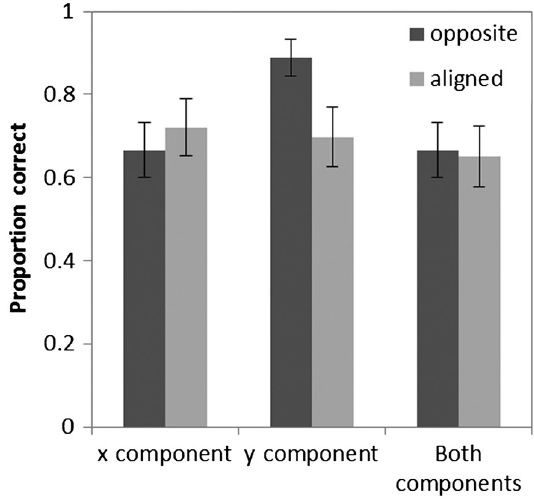
FIG. 5. Student performance ( N ¼ 94 , semester 2) on sub- traction of two vectors in the arrow format for cases in which either components in both dimensions were in the same direction (aligned) or components in one dimension were aligned and components were opposed in the other dimension (see Fig. 3). For the latter case, the x components were in opposing directions and the y components were in the same direction. The categories represent the proportion of students correctly subtracting the x components (which were opposed or aligned), the y components (which were aligned), and the combined total scores of both components. Error bars indicate (cid:2) 1